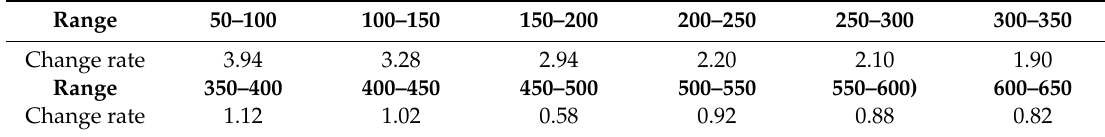
Table 3. Change rate of high-subsidence gradient areas between two adjacent bu ff er zones.